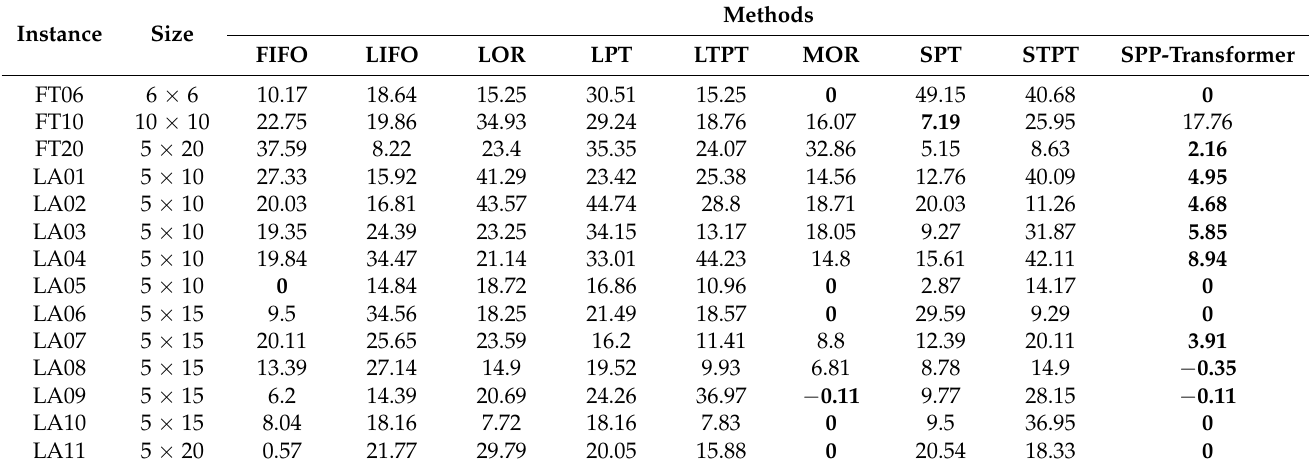
Table A2. The comparison between simple priority rules and SPP-Transformer on RPD